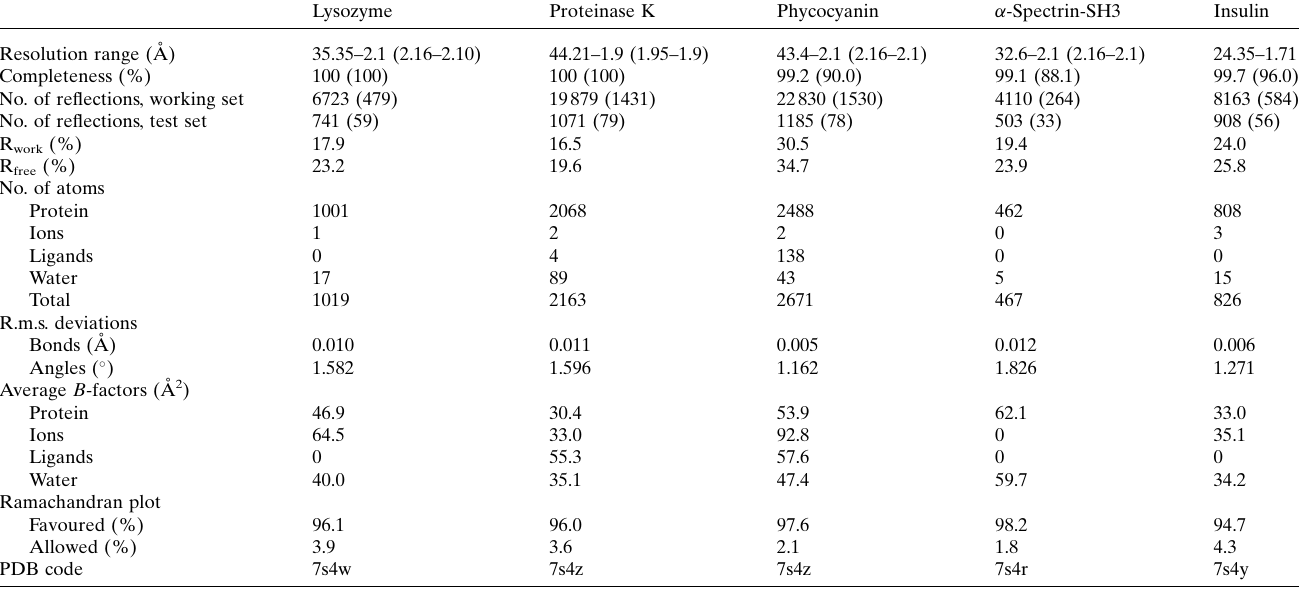
Table 2 Data refinement statistics (values in parentheses are for the high-resolution